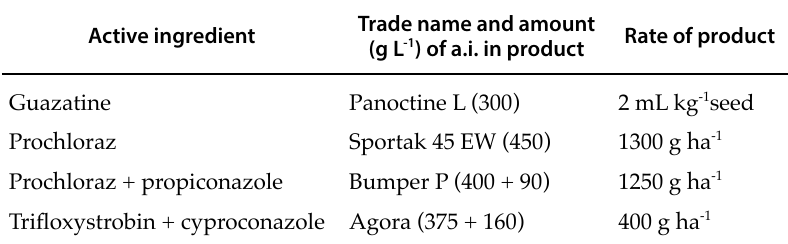
Table 1. Seed dressing and foliage fungicides used in trials performed during the period 2006‒2009 in the Po Valley (Italy). Active ingredient